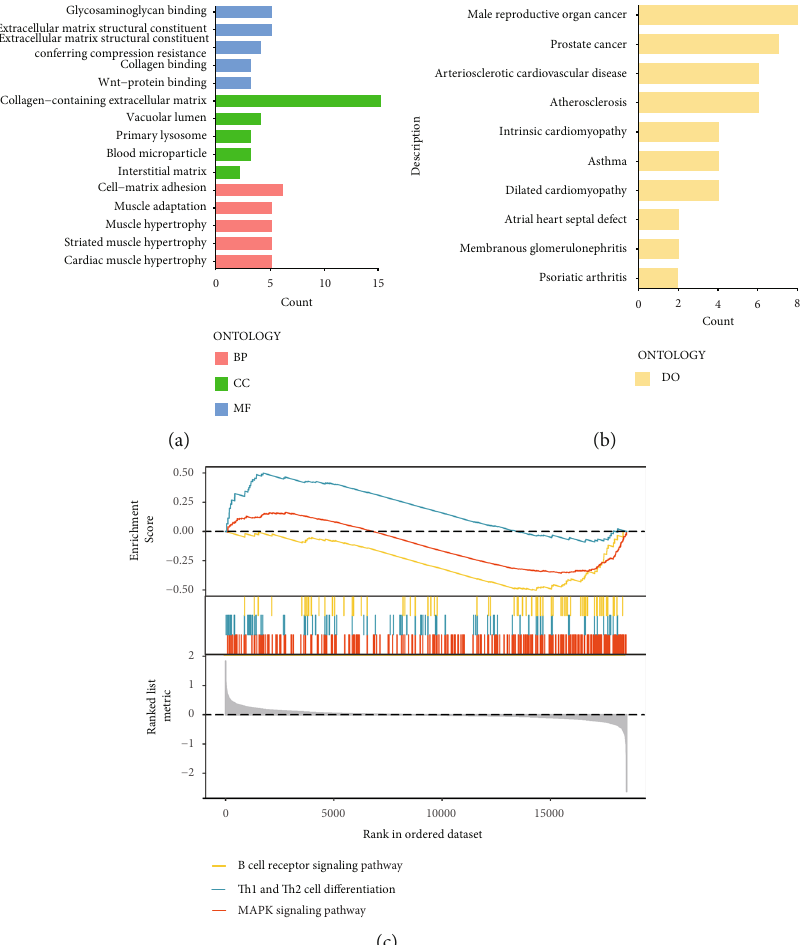
Figure 2: Multiple enrichment analysis results. (a) Gene Ontology (GO) enrichment. The red bar represents the number of pathways in the BP part, the green bar represents the number of pathways in the CC part, and the blue bar represents the number of pathways in the MF part; (b) Disease Ontology (DO) enrichment. The yellow bars represent the number of pathways in the DO part; (c) GSEA-enriched pathways. Yellow lines represent B cell receptor signaling pathway, red lines represent MAPK signaling pathway, and blue lines represent Th1-Th2 cell di ff